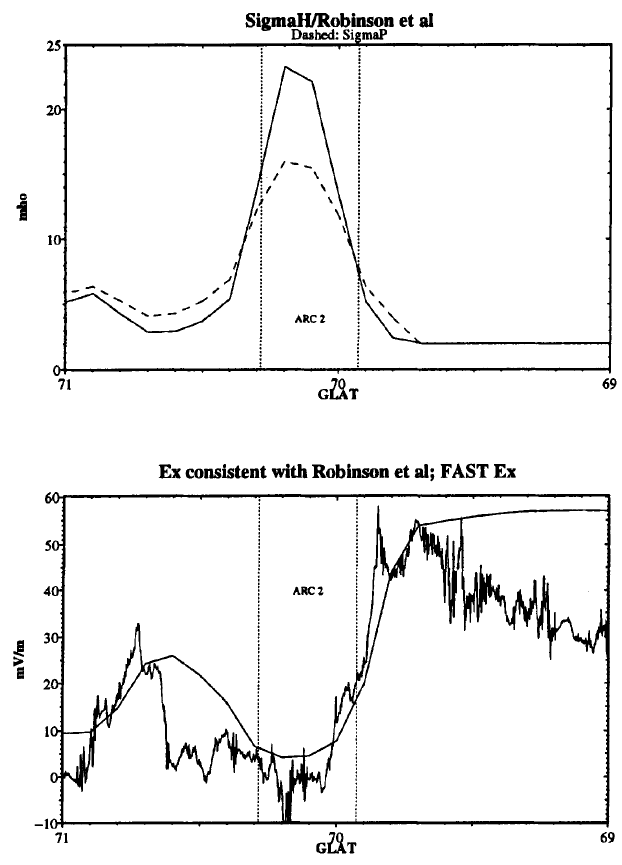
Fig. 11. Top , height-integrated ionospheric Hall ( solid line ) and Pedersen ( dashed ) conductivity as determined from FAST electron data using formulas of Robinson et al. (1987). Conductivities smaller than 2 mho have been set to 2 mho. Bottom , northward electric field inferred from the ground magnetograms and the conductivities in the top panel ( smoother curve ), and FAST northward electric field ( jagged